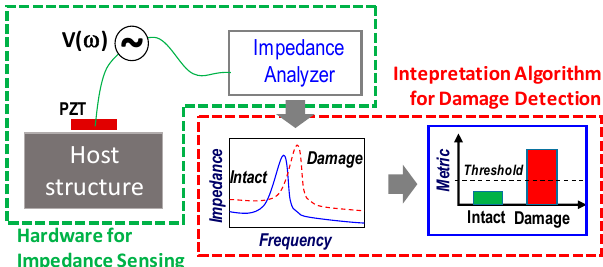
Figure 6. Scheme of the impedance-based SHM process.